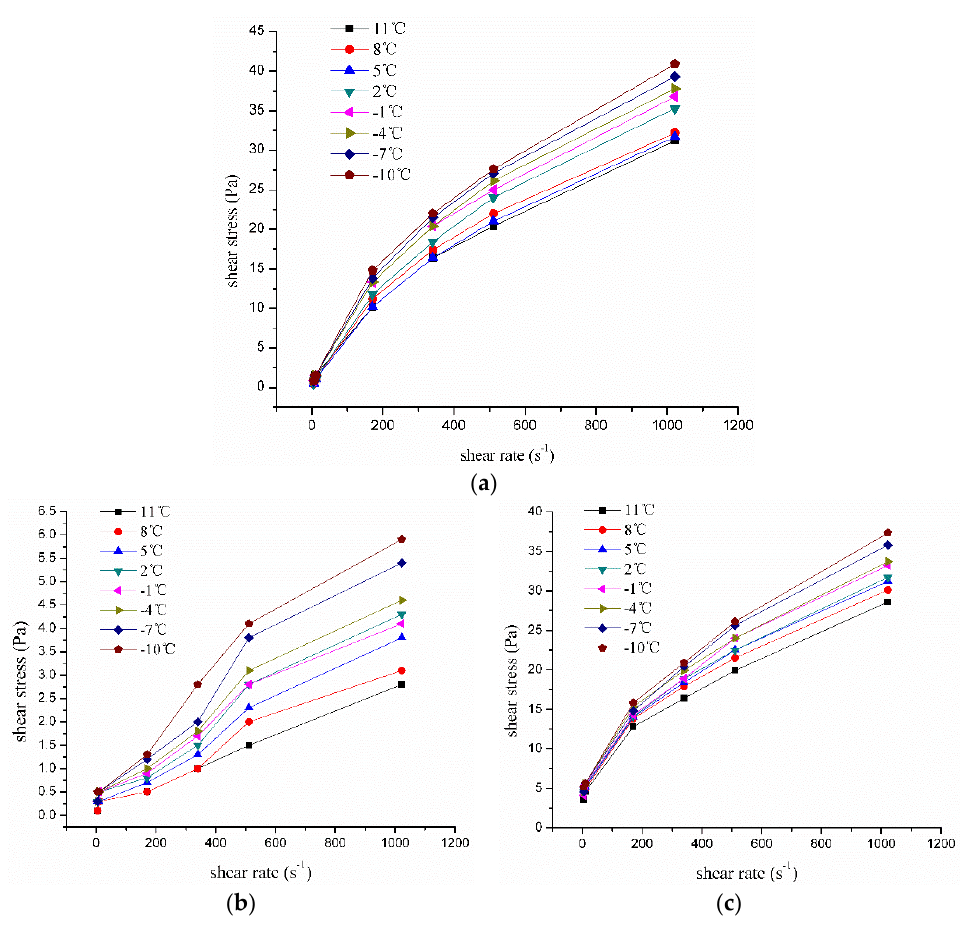
Figure 2. Shear stress with shear rate curves of three types of polymer drilling fluid at different temperatures. ( a ) Shear stress with shear rate curve of KL polymer drilling fluid shear stress with the shear rate curve; ( b ) Shear stress with the shear rate curve of PAM polymer drilling fluid; and ( c ) shear stress with the shear rate curve of XC polymer drilling fluid.